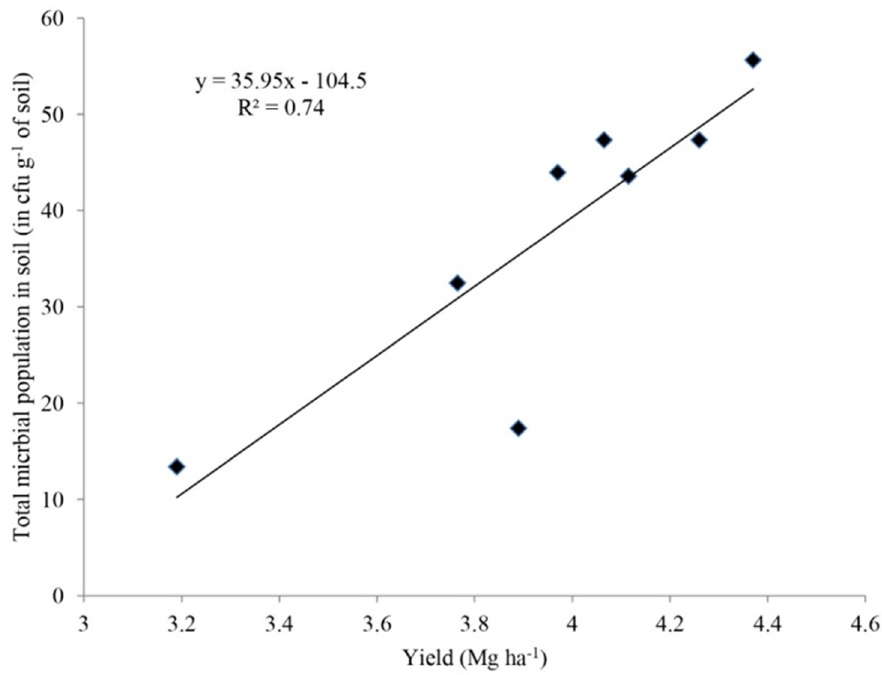
Figure 2. Relationship between yield and total soil microbial population.